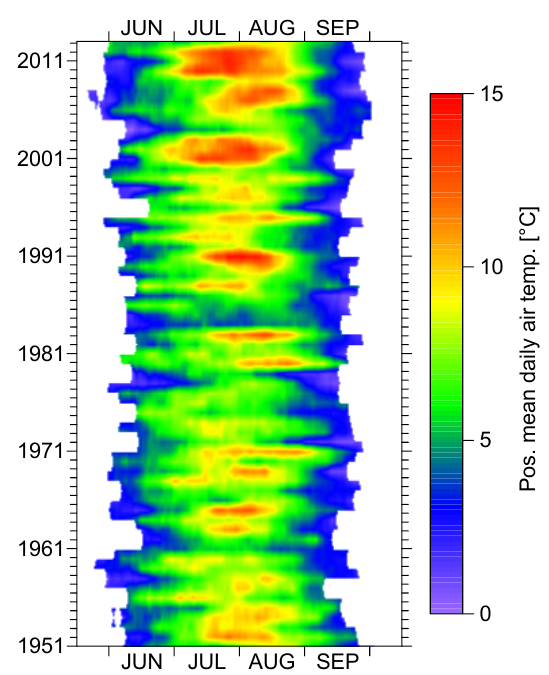
Figure 19. Time series of positive mean daily T air over the period from 1951 to 2013 show lengthening and intensification. Seasonal duration available for thermo-denudation lengthened from 111 days for the entire period to 127 days on average for complete years of the current observation period (2010–2012). Simultaneously, positive mean daily T air was currently 1.4 ◦ C higher and increased from 5.9 to 7.3 ◦